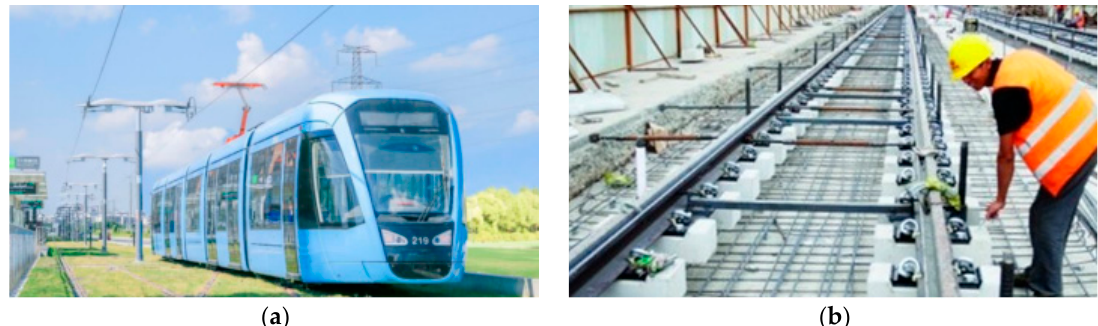
Figure 1. Tram and track structure. ( a ) Tram and ( b ) track construction site.